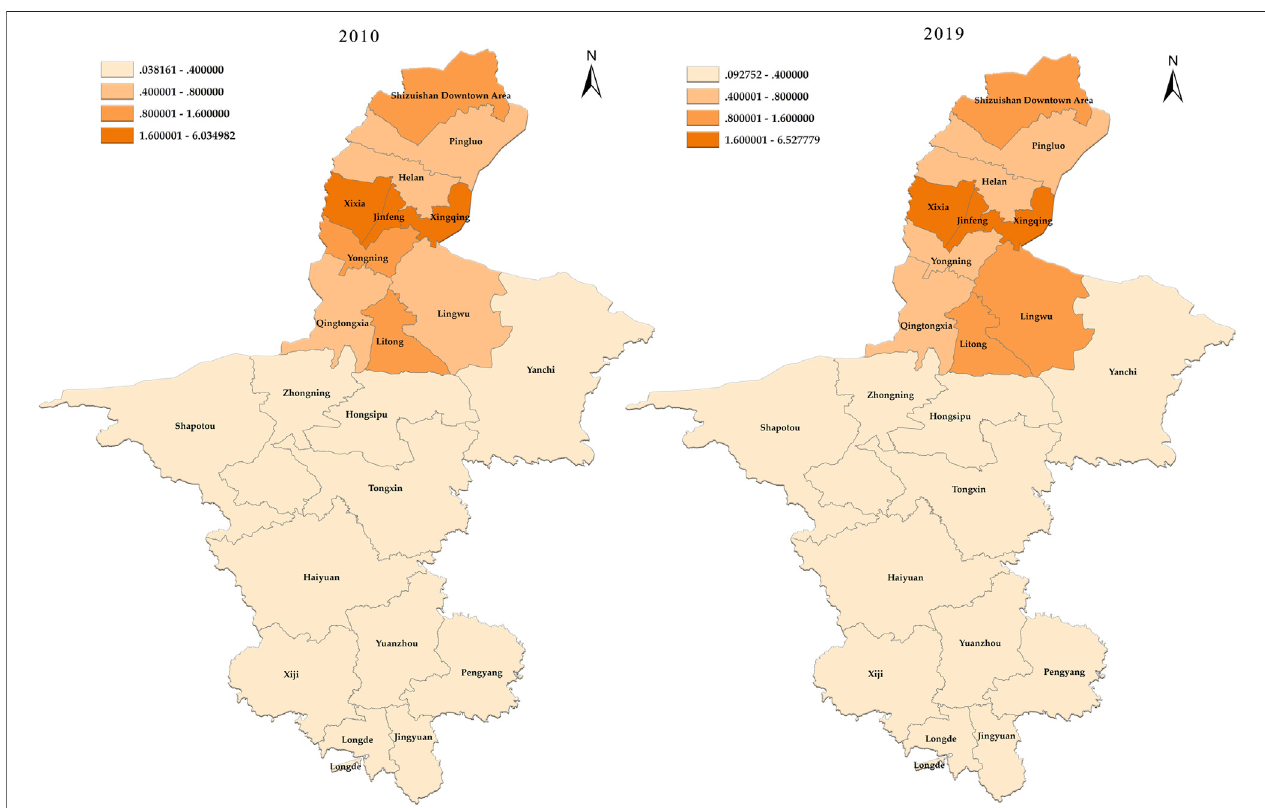
FIGURE 6 | The geographical concentration of Ningxia ’ s economy in 2010 and